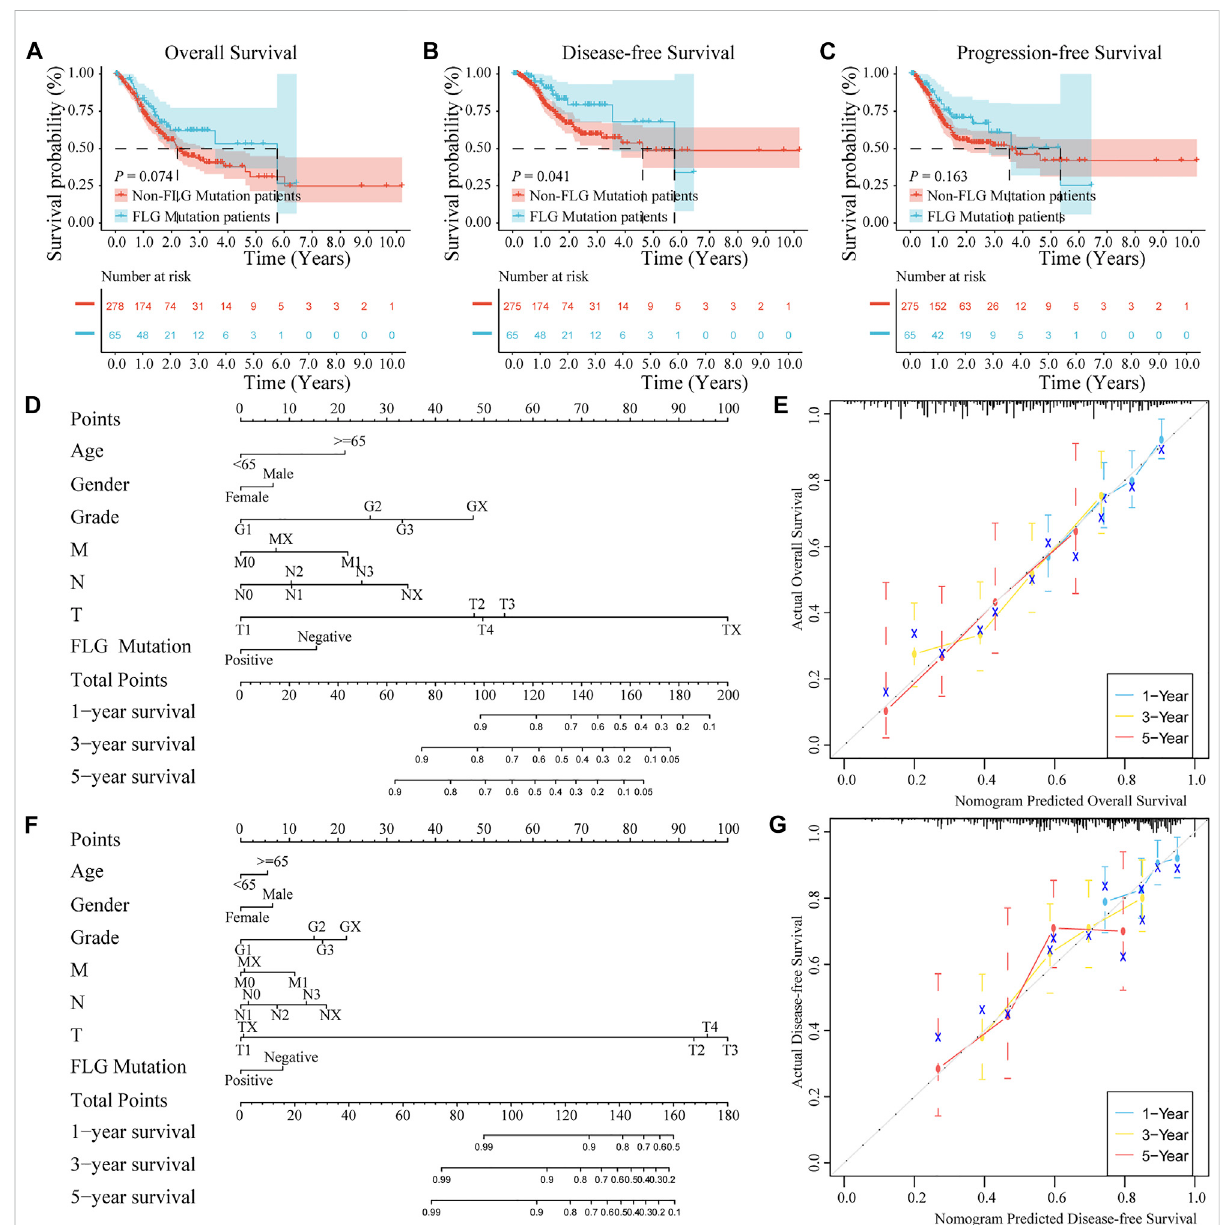
FIGURE 5 Effects of FLG gene mutationon clinicopathological features inthe TCGA-STAD dataset. (A – C) In theTCGA-STAD dataset, thesurvival analysis showed that OS (log-rank p = 0.074) and DFS (log-rank p = 0.041) were better in patients with FLG gene mutations, but no signi fi cant impact on PFS (log-rank p = 0.163). (D) OS nomogram was constructed by the mutation of FLG gene combining with clinicopathological features. (E) Calibration curve of the FLG gene mutation nomogram. The abscissa axis is predicted survival, the ordinate axis is observed survival, every calculation is repeated 1,000 times. The calibration plots demonstrate good agreement between the predictions made by the nomogram and actual prognosis of patients for 1-,3-, and 5 years. (F) Nomogram constructed by the mutation of FLG gene combining with clinicopathological features. (G) Calibration curve of the nomogram of FLG gene mutation. The abscissa axis is predicted survival, the ordinate axis is observed survival, every calculation is repeated 1,000 times. The calibration plots demonstrate good agreement between the predictions made by the nomogram and actual prognosis of patients for 1-,3-, and 5